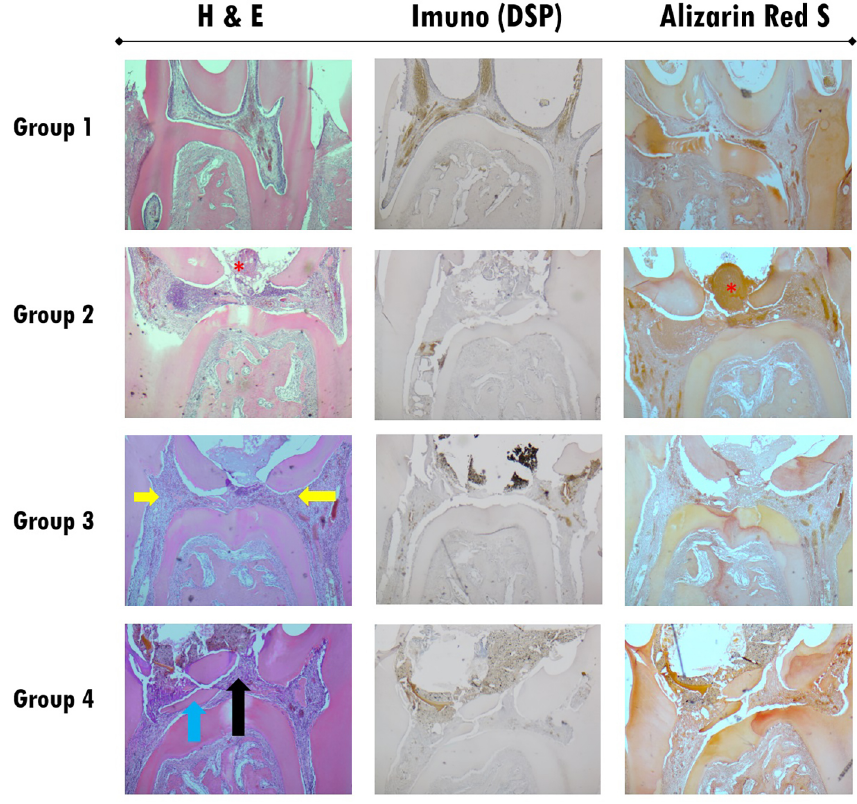
Figure 8- Histological sections images of all studied groups at seven days follow-up, stained with H&E (left column), with immunohistochemistry for DSP (central column) and with Alizarin Red S (right column). All images were obtained with 40x magnification. In Group 2, the pulp polyp is visible with a disorganization of the tissue inside the pulp chamber (red asterisk). In Group 3, shows a decrease in inflammatory infiltrate without mineralized tissue formation (yellow arrows). Group 4 shows an intense inflammatory infiltrate especially in the area near the exposure (black arrows) and the formation of small focuses of mineralized tissue in the exposure location (blue arrows)